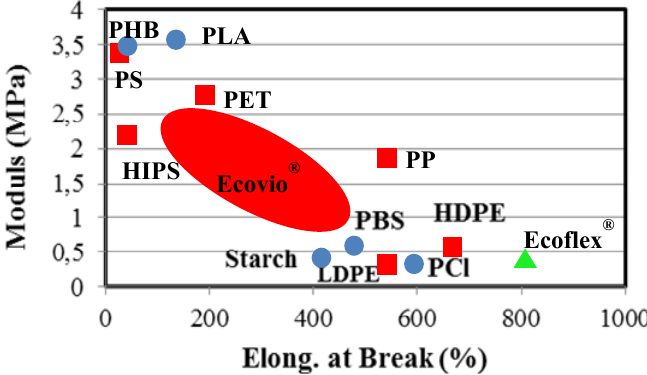
Figure 8. Comparison between mechanical properties of Ecoflex™, Ecovio™ and representative commodity